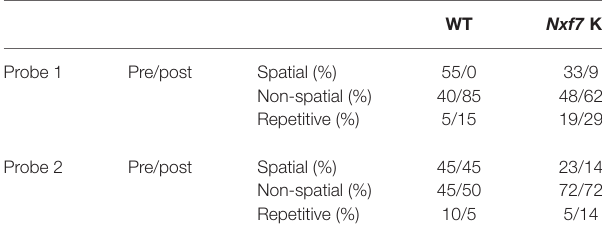
TABLE 2 | Search strategies employed during probe